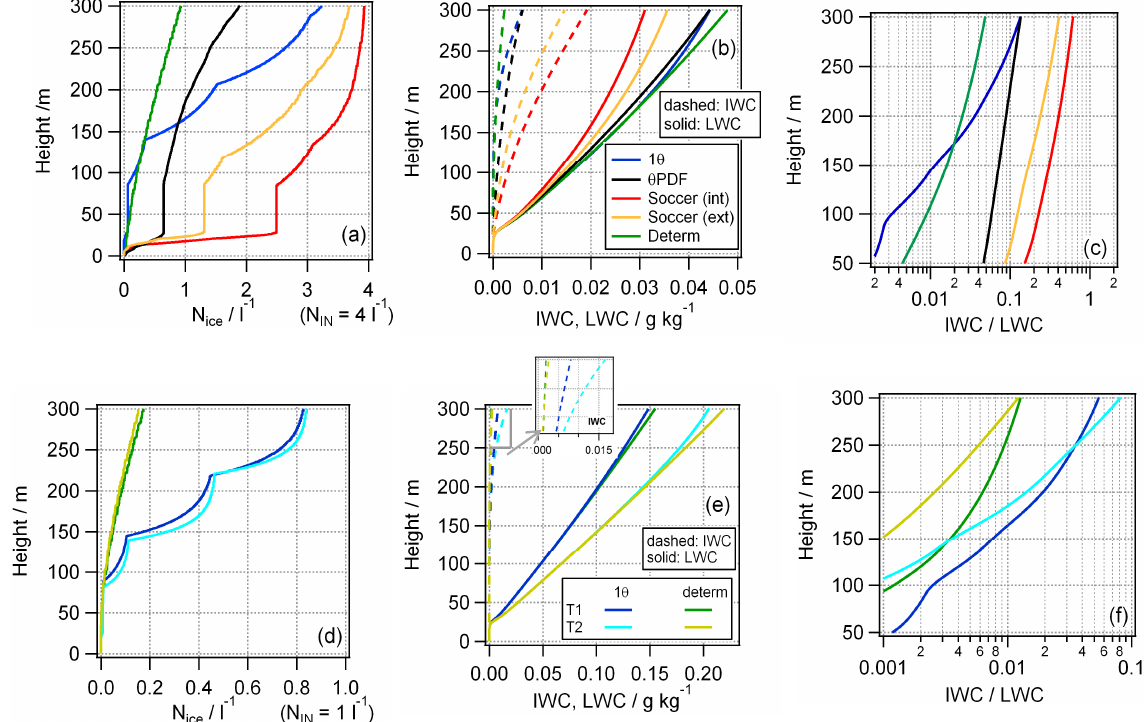
Figure 8. Parcel model results of (a, d) the evolution of the ice number concentration N ice of an IN population with N IN , (b, e) IWC, LWC, and (c, f) IWC/LWC assuming a polydisperse IN size distribution. The upper panel corresponds to immersion/condensation freezing of kaolinite; the bottom panel includes results for simulations at temperature regimes T1 and T2.